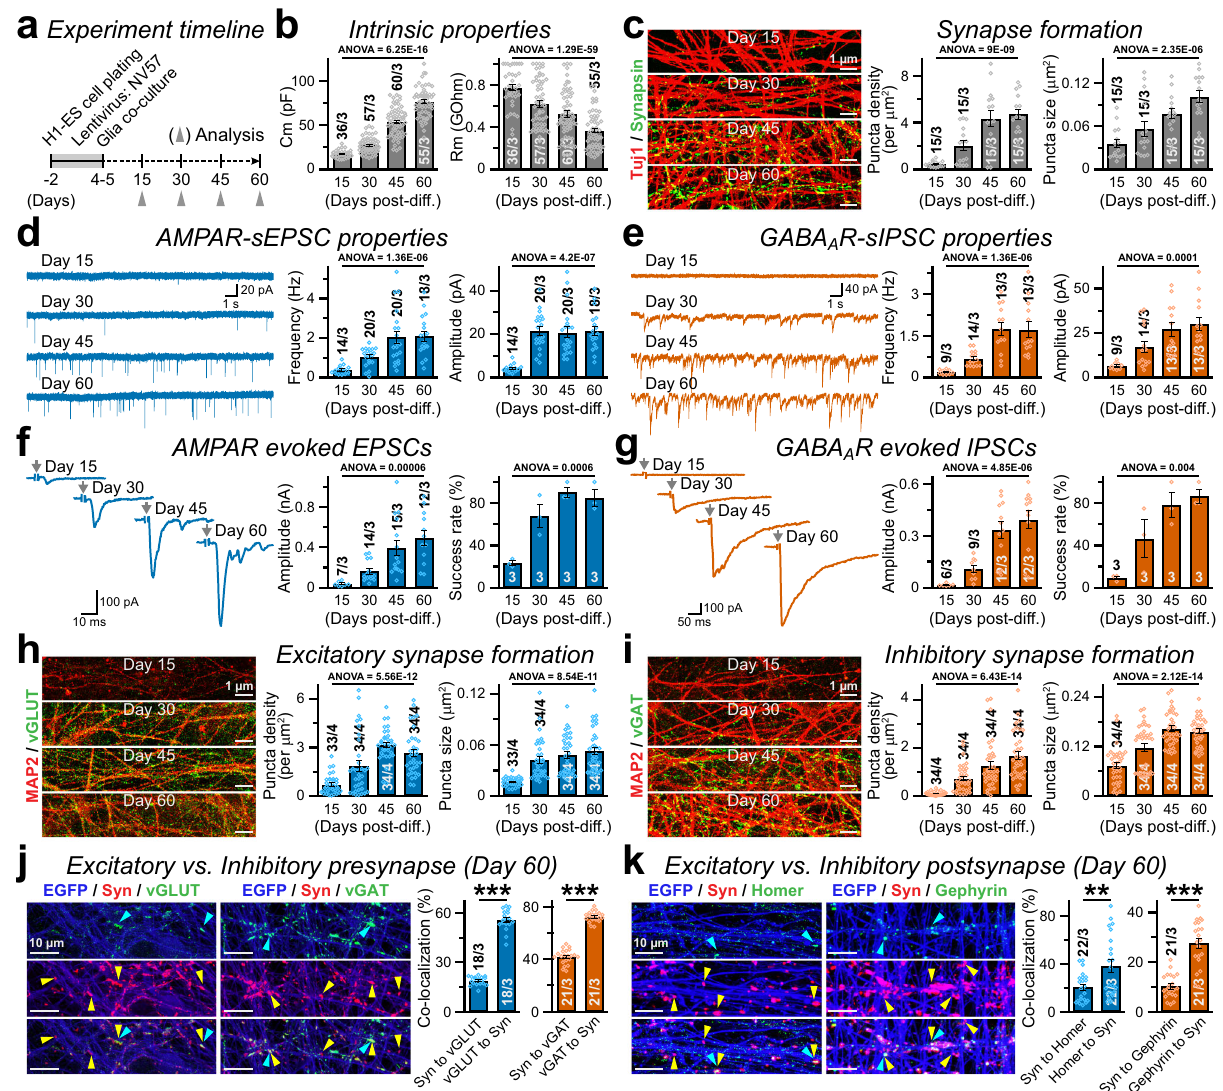
Fig. 4 Induced GABAergic synapses mature rapidly, in parallel with glutamatergic synapses. a Experimental protocol for b – k ; Ngn2-induced human neurons were additionally infected with viruses expressing V57 factors, and analyzed every 15 days starting from post-induction day 15 until day 60. b Summary graphs of C m (left) and R m (right) values, at different time-points of neuronal maturation. c Example images (left) and average density or size (right) of Synapsin puncta constituted on Tuj1-positive neurites, as measured from NV57 neurons at different stages of their in vitro development (see annotated). d , e Sample traces (left) and average parameters (right, event frequency or amplitude) of AMPAR-mediated sEPSCs d and GABA A R sIPSCs e recorded in the presence of PTX and CNQX, respectively, at day 15 – 60. f , g Stimulation-evoked EPSCs ( f , with PTX) and IPSCs ( g , with CNQX) recorded at indicated time-points; example traces (left), average amplitudes (middle), and percentage of cells with detectable responses (right). h , i Same as c , except for vGLUT ( h ) or vGAT ( i ) puncta formed on MAP2-positive dendritic branches. j . Representative images (left) and Mander ’ s coef fi cients (right) of co-localization between Synapsin puncta and either vGLUT or vGAT signals. Neurites were visualized by co-expression of soluble EGFP. Both vGLUT and vGAT signals individually occupy only a fraction of Synapsin-positive total synapses at day 60. k Same as j , except for co-localization between Synapsin and either Homer or Gephyrin, at day 60. All data represent means ± SEM. Summary graphs also denote the total number of fi eld-of-views analyzed (for immunostaining) or neurons patched (for electrophysiology)/independent batches, and individual data-points (open circles). Statistical signi fi cance for normally distributed data (Skewness and Kurtosis values between − 2 and 2) in panels j and k was calculated by two-tailed, unpaired, Student ’ s t-test,